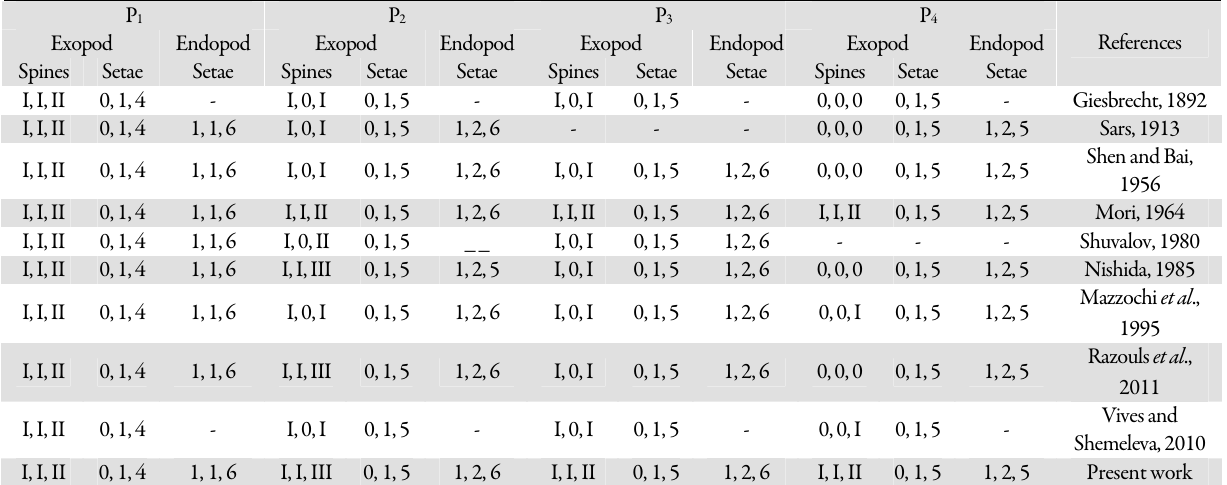
to P ) of female Oithona 1 4